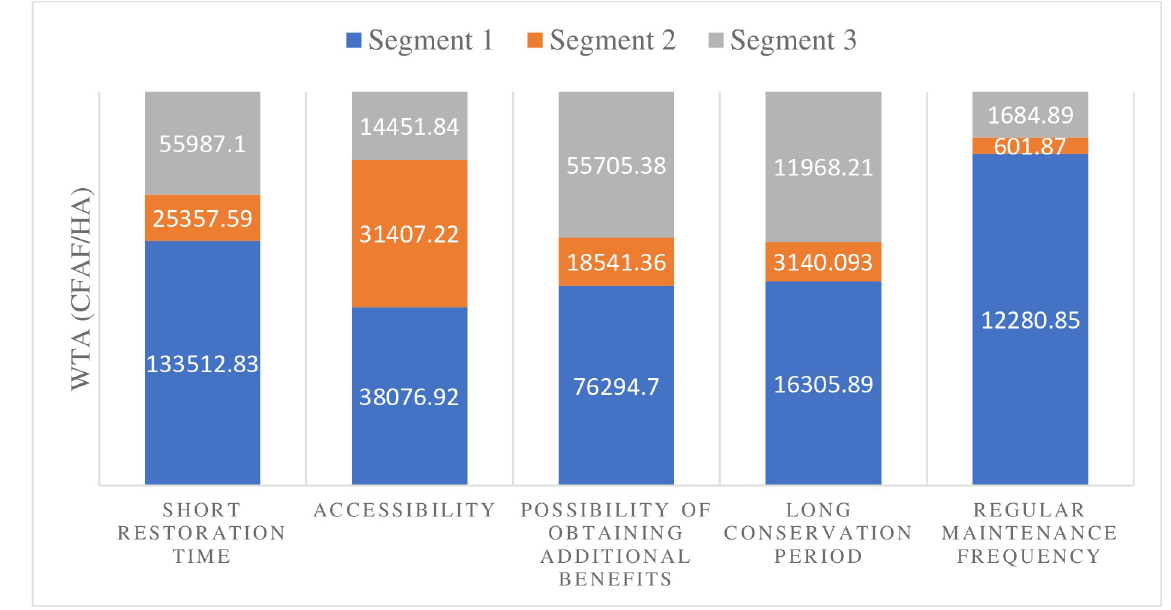
Fig 4. Estimate of the willingness-to-adopt from the three latent classes